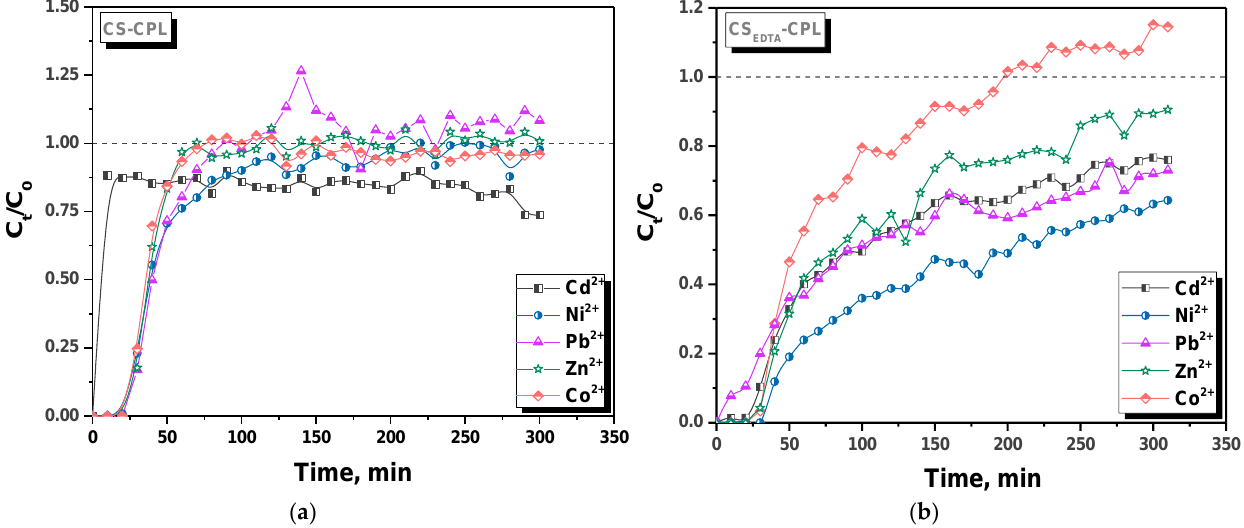
Figure 3. Experimental breakthrough curves for individual HMIs sorption from simulated multicomponent solutions by CS-CPL ( a ) and CS EDTA -CPL ( b ) microbeads in fixed-bed column experiments.